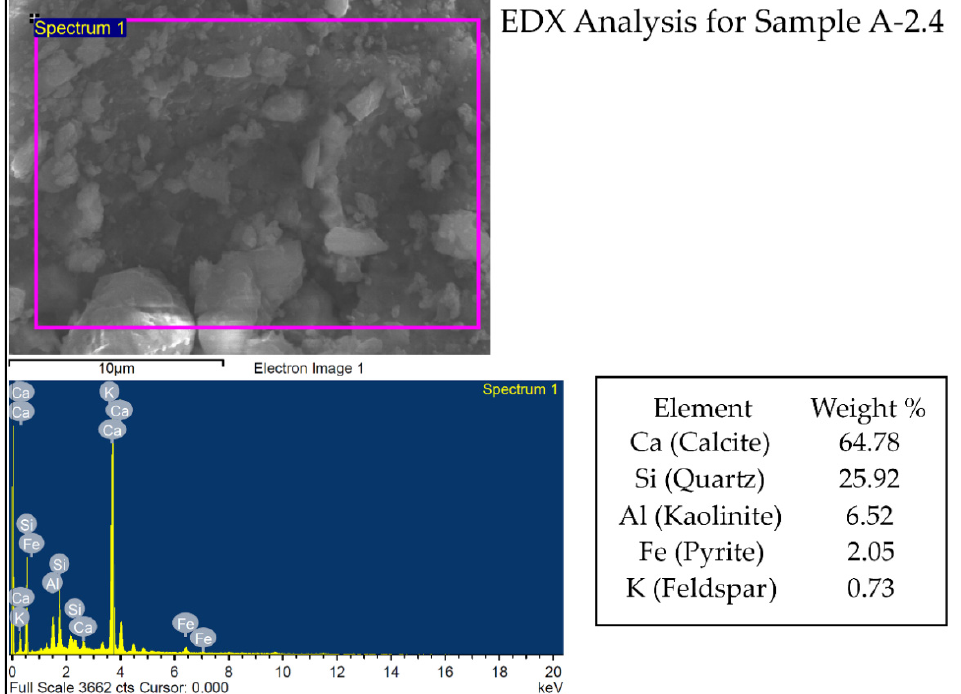
Figure 5. EDX analysis of sample A-2.4.